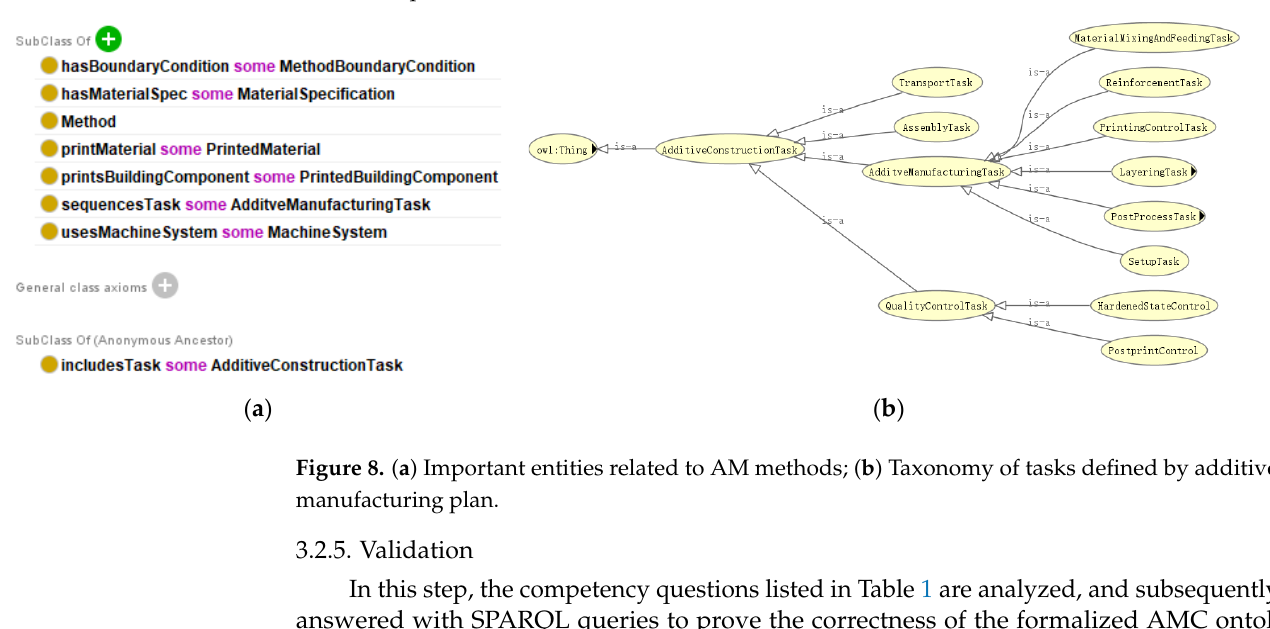
Figure 7. Excerpt of formalized AMC ontology. The black solid line segments recognize relevant terms as requirements and constraints.